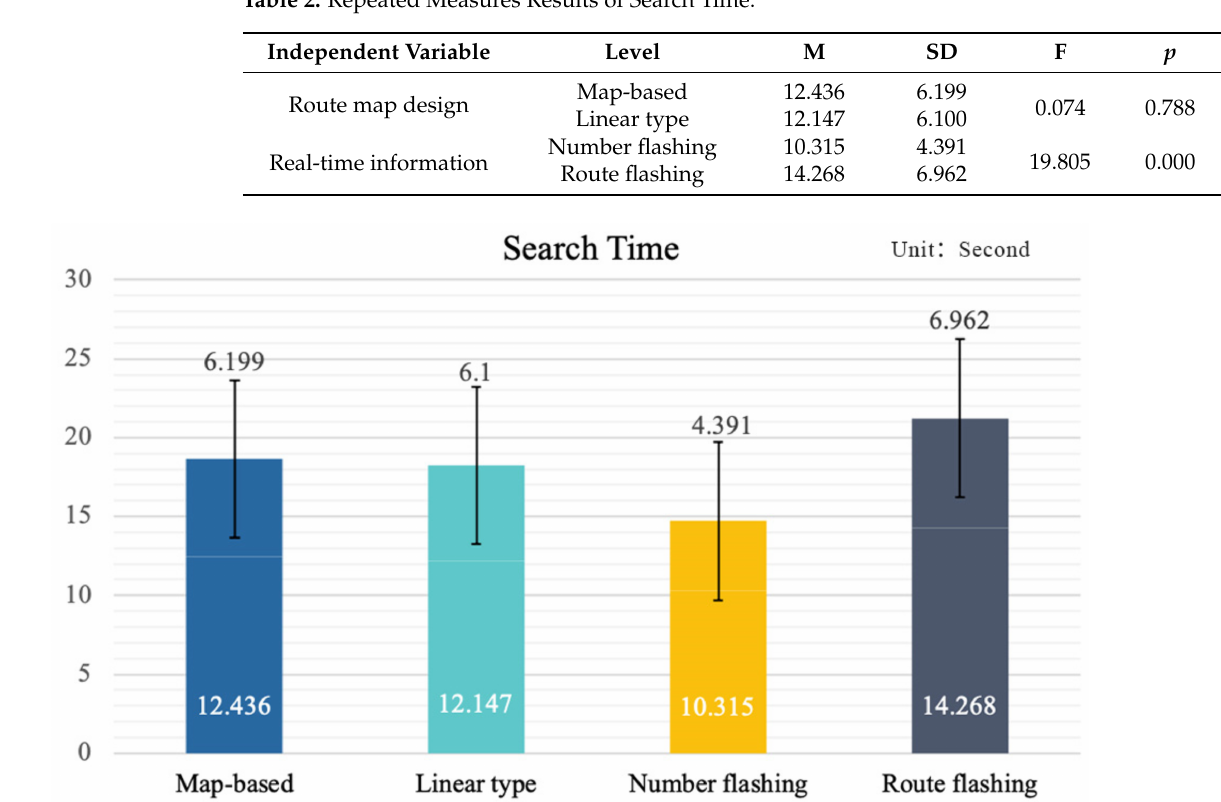
Figure 6. Results of search time.